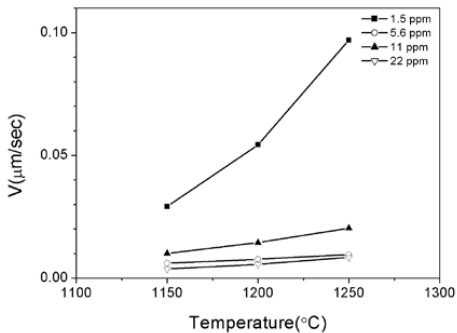
Figure 8. The grain boundary velocity (V) in terms of annealing temperature after 20 min of annealing time.